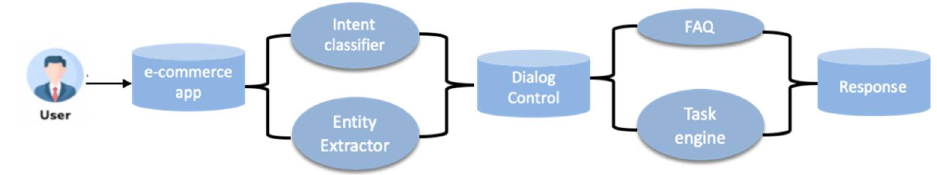
Figure 1. Structure of BERT model. Figure 1. Workflow of an e-commerce